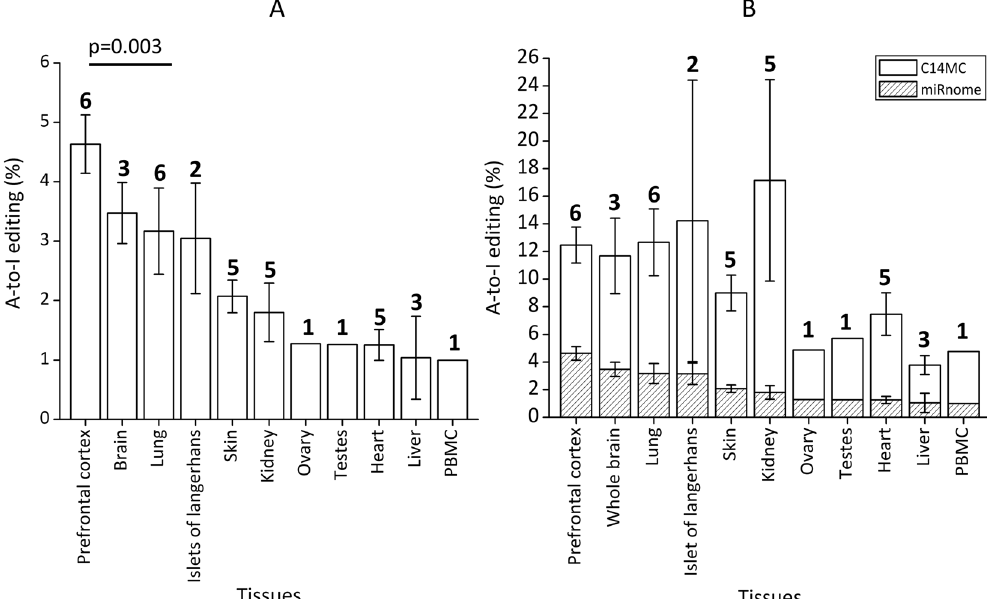
Figure 1. Distribution of A-to-I editing in different healthy human tissues. ( A ) A-to-I editing in mature miRNAs is the highest in Prefrontal cortex (two-tailed t-test; p = 0.003 with respect to lung samples). Percentage A-to-I editing was calculated by dividing the number of edited miRNAs by the total number of miRNAs expressed with a read count greater than equal to 10. The numbers above the bars represent the number of different individuals analysed. ( B ) C14 miRNA cluster show enriched A-to-I editing. The fraction of edited miRNAs from C14 was significantly higher compared to the miRnome average in all tissues analyzed (p < 0.008), the tissues have been arranged according to descending order of miRnome-wide